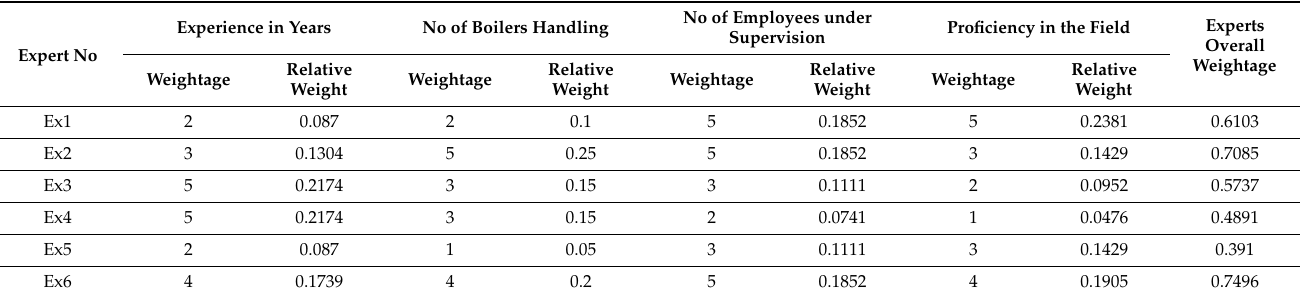
Table 8. Experts overall weight values.